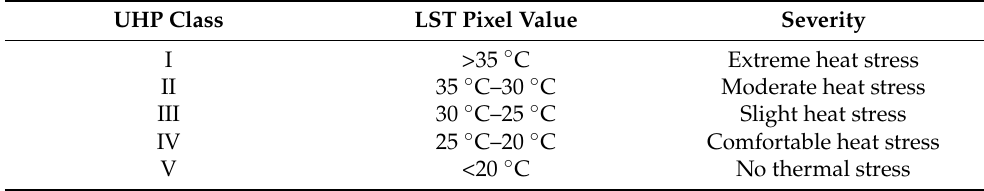
Table 2. Classification of urban heat pockets.